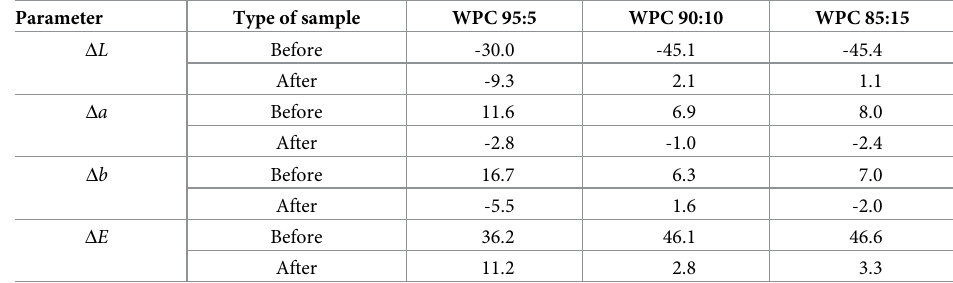
Table 4. Results of color analysis before and after the 50-day graveyard